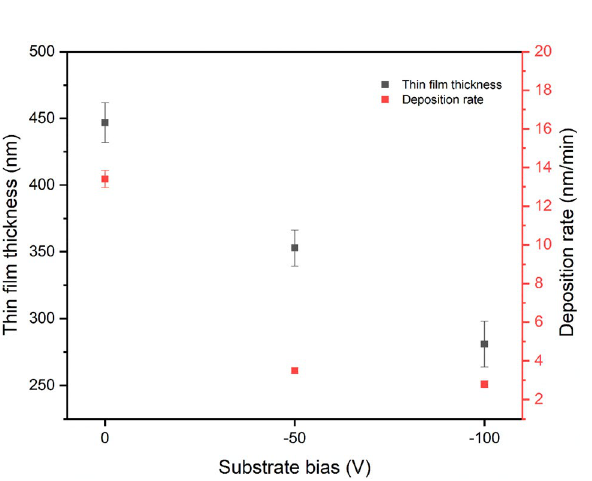
Figure 3. Average ion implantation range as a function of substrate bias for all of the elements into the substrate of SiO 2 .